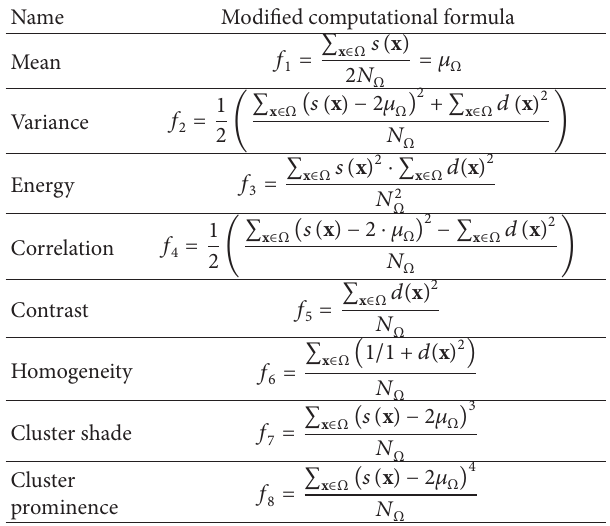
Table 1: Modified definitions of Unser